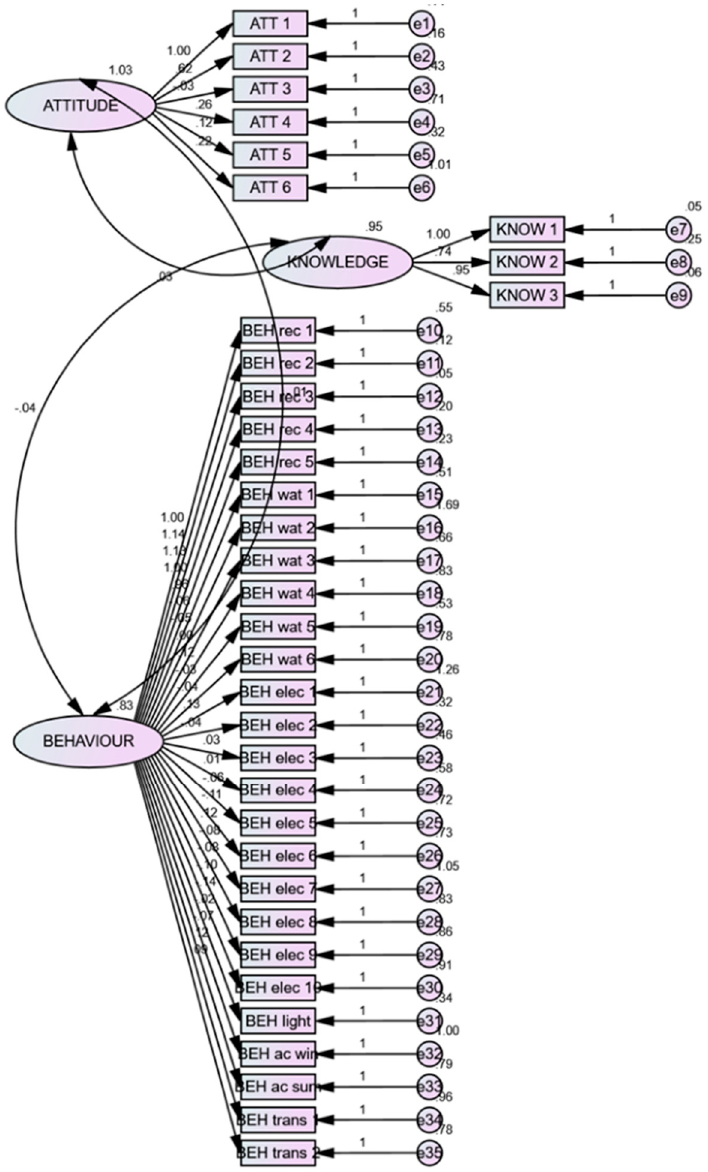
Figure 6. Conceptual measurement model of interrelation between building occupants environmental AKB. t < 12 × s(s + 1)